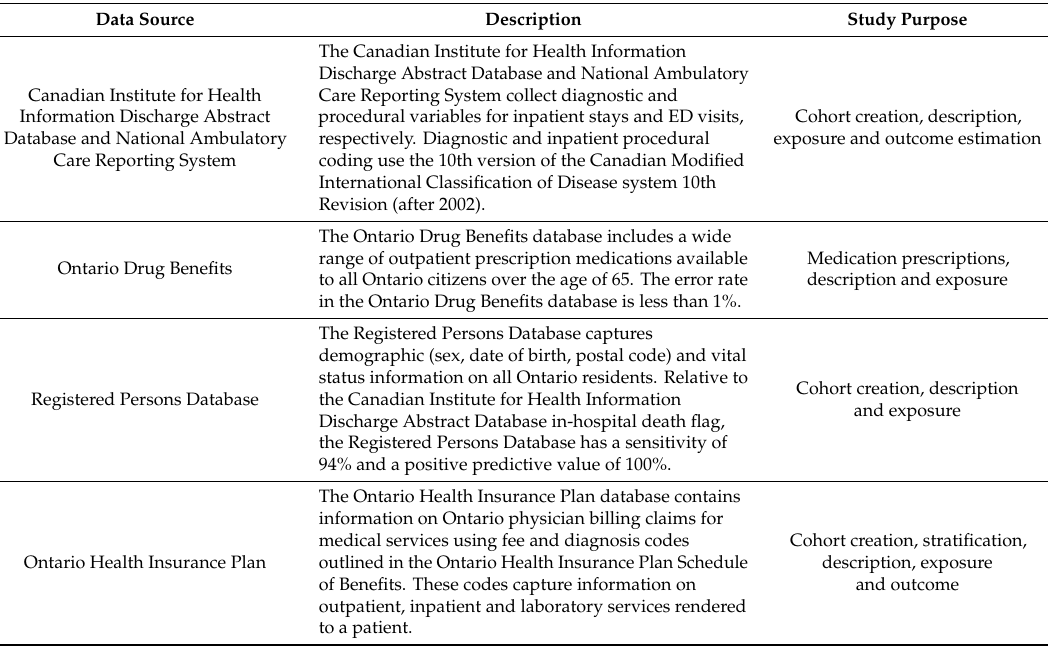
Table A1. List of databases held at ICES.